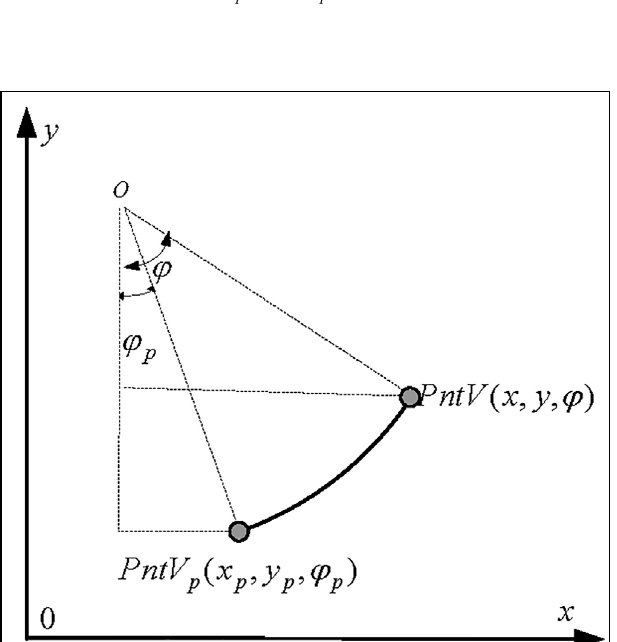
FIGURE 6 | Position calculation diagram at preview